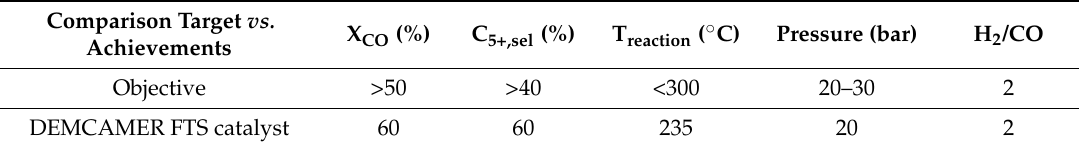
Table 3. Compliance of FTS catalyst developed in DEMCAMER with the requirements of activity and